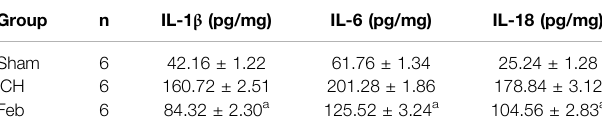
TABLE 1 | IL-1 β , IL-6, and IL-18 levels in the sham, ICH, and feb groups.